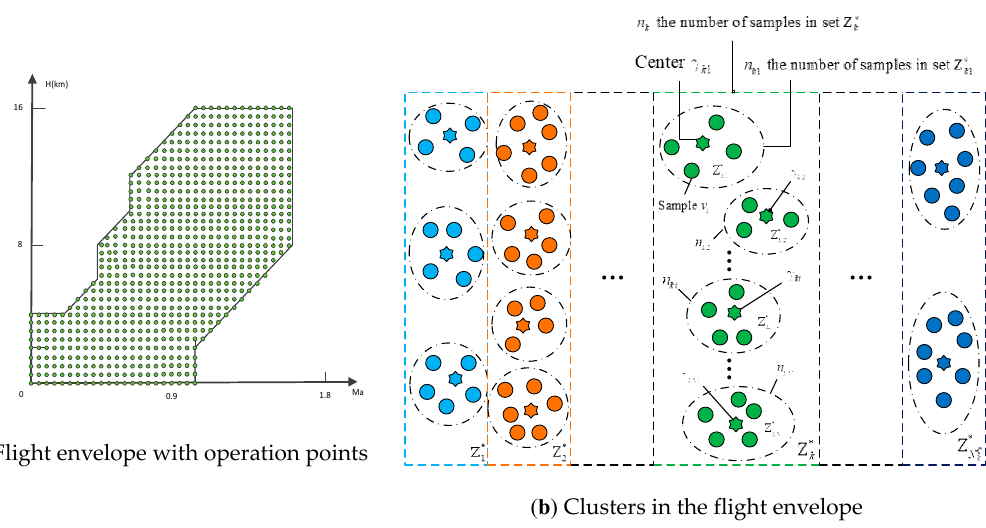
Figure 2. Schematic diagram of clustering in the flight envelope.